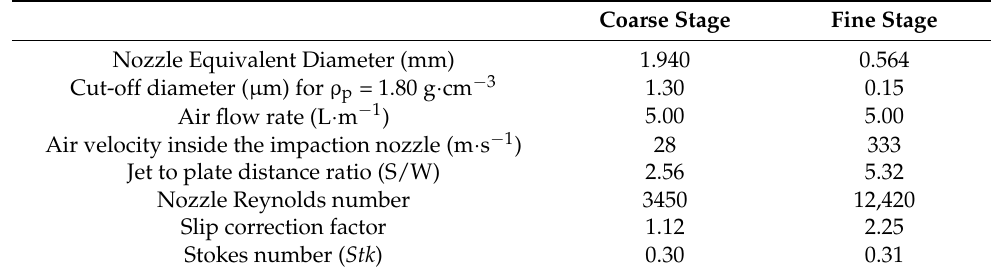
Table 1. Theoretical calculations of the stage parameters of the TRAPS at T = 293 K and p = 101.3 kPa. Coarse Stage Fine Stage Nozzle Equivalent Diameter (mm) 1.940 0.564 Cut-off diameter ( µ m) for ρ p = 1.80 g · cm −